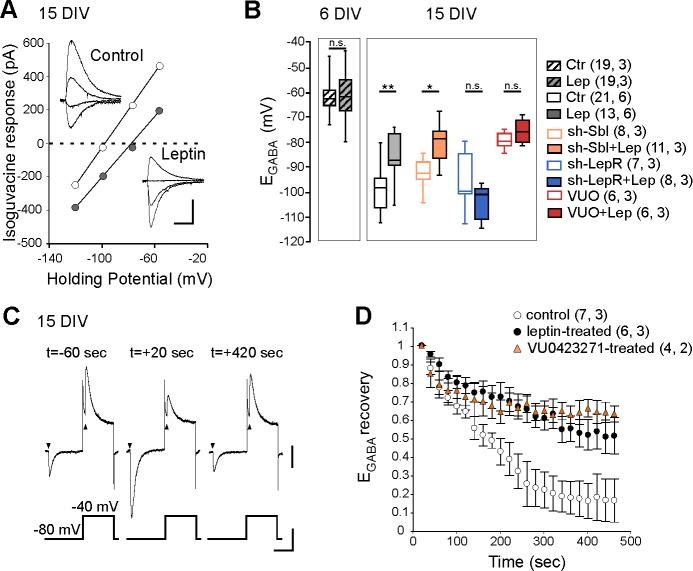
Leptin down-regulates KCC2 activity in cultured hippocampal neurons.(A) I-V relationships for isoguvacine currents in vehicle (control) and leptin-treated (100 nM, 24 hr) hippocampal (15 DIV) cultures. Gramicidin perforated patch clamp recordings. Insets depict the isoguvacine currents. Scale bar, 500 ms, 100 pA. (B) Box plots of EGABA in the indicated conditions. *p<0.05, **p<0.01, ANOVA followed by a Tukey’s post hoc test. (C) Examples of isoguvacine currents (arrow heads) recorded at −80 and −40 mV before (t=-60 sec) and after (t = +20 and +420 s) neuronal chloride loading in control neuronal culture (15 DIV). Gramicidin perforated patch clamp recordings. Scale bar, 100 pA, 40 mV, 1 s. (D) Summary plots of normalized EGABA recovery after neuronal chloride loading in the indicated conditions. Mean ± SEM. In B and D, the number of cells recorded and number of cultures used are indicated in parenthesis.10.7554/eLife.36726.009Figure 2—source data 1.Leptin decreases KCC2 activity in cultured hippocampal neurons.